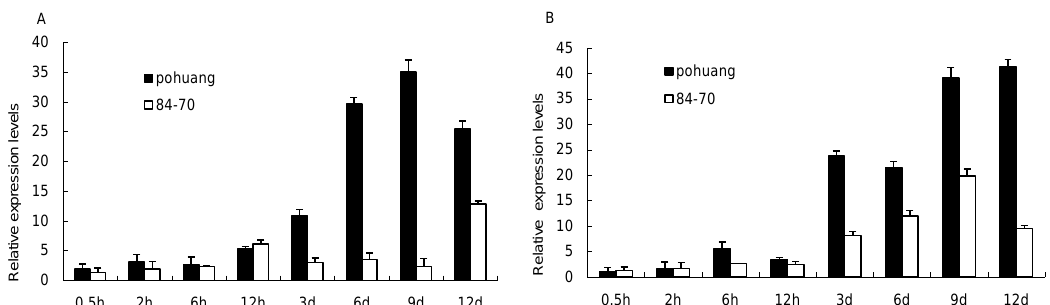
Fig. 4 The GmCBS21 transcript is induced by low nitrogen stress (A) The expression in leaf Figure 4. The GmCBS21 transcript is induced by low nitrogen stress: ( A ) The expression in leaf and and stem ;( B) The expression in root. Three independent experiments were performed, and stem; ( B ) The expression in root. Three independent experiments were performed, and values are values are shown as means and error bars indicate standard deviation (n=3) shown as means and error bars indicate standard deviation ( n = 3).